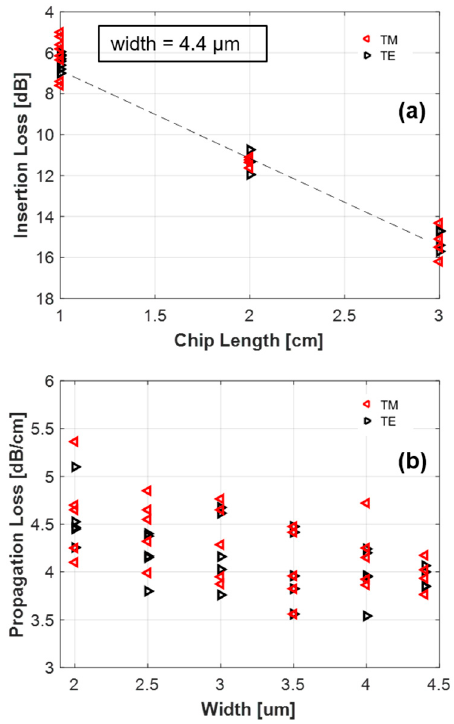
Figure 9. ( a ) Insertion loss plot of the SiOC waveguides with different chip lengths (1–3 cm), ( b ) SiOC waveguides propagation losses as a function of width (2–4.4 µ m) for both TE and TM polarizations.